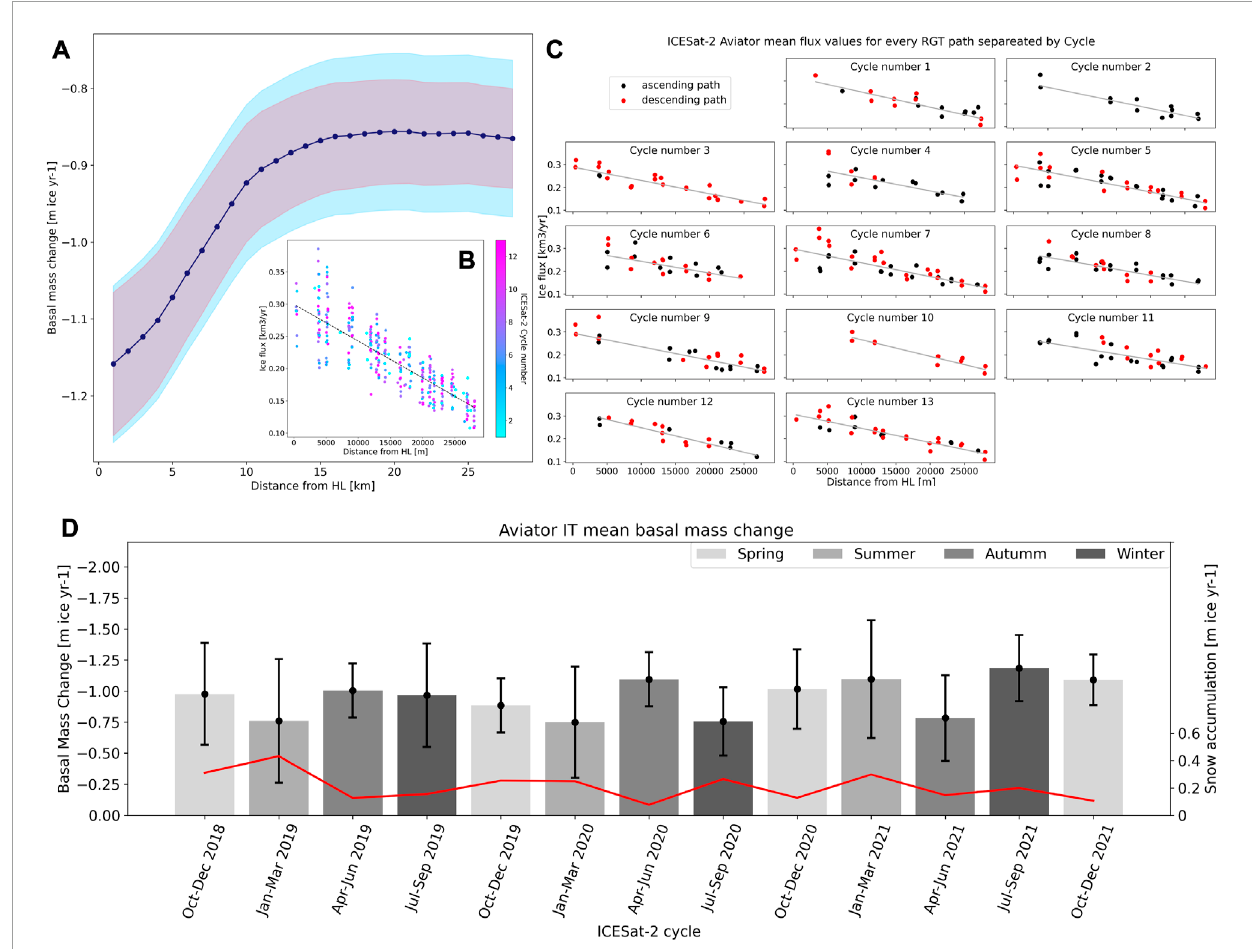
FIGURE 6 Aviator (A) Basal melt between flowlines over the free-floating area of the ice tongue, derived from all the ICESat-2 data. The basal melt derived from the linear model confidence interval is shown in red, and the standard deviation of the basal melt is in light blue. (B) Ice flux derived from all cycles with fitted linear regression in black. The different cycles are shown in a colour map from cycle-1 in light blue to cycle-13 in pink. (C) Ice flux per cycle for every ICESat-2 track, with red showing the descending tracks and in black the ascending tracks. Every cycle has a fitted linear regression shown in grey. (D) Aviator spatially averaged basal melt rates, with the axis inverted for clarity. More negative numbers imply larger mass loss, and the different seasons are depicted in a grey colour scheme. With darker grey for winter and lighter grey for summer. The snow accumulation rate in m of ice over the same period is shown in red. The snow accumulation values are derived from ERA5-land and are scaled to the same period as the ICESat-2